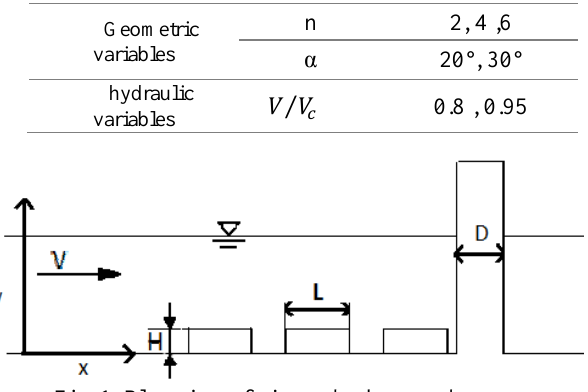
Fig. 1. Plan view of pier and submerged